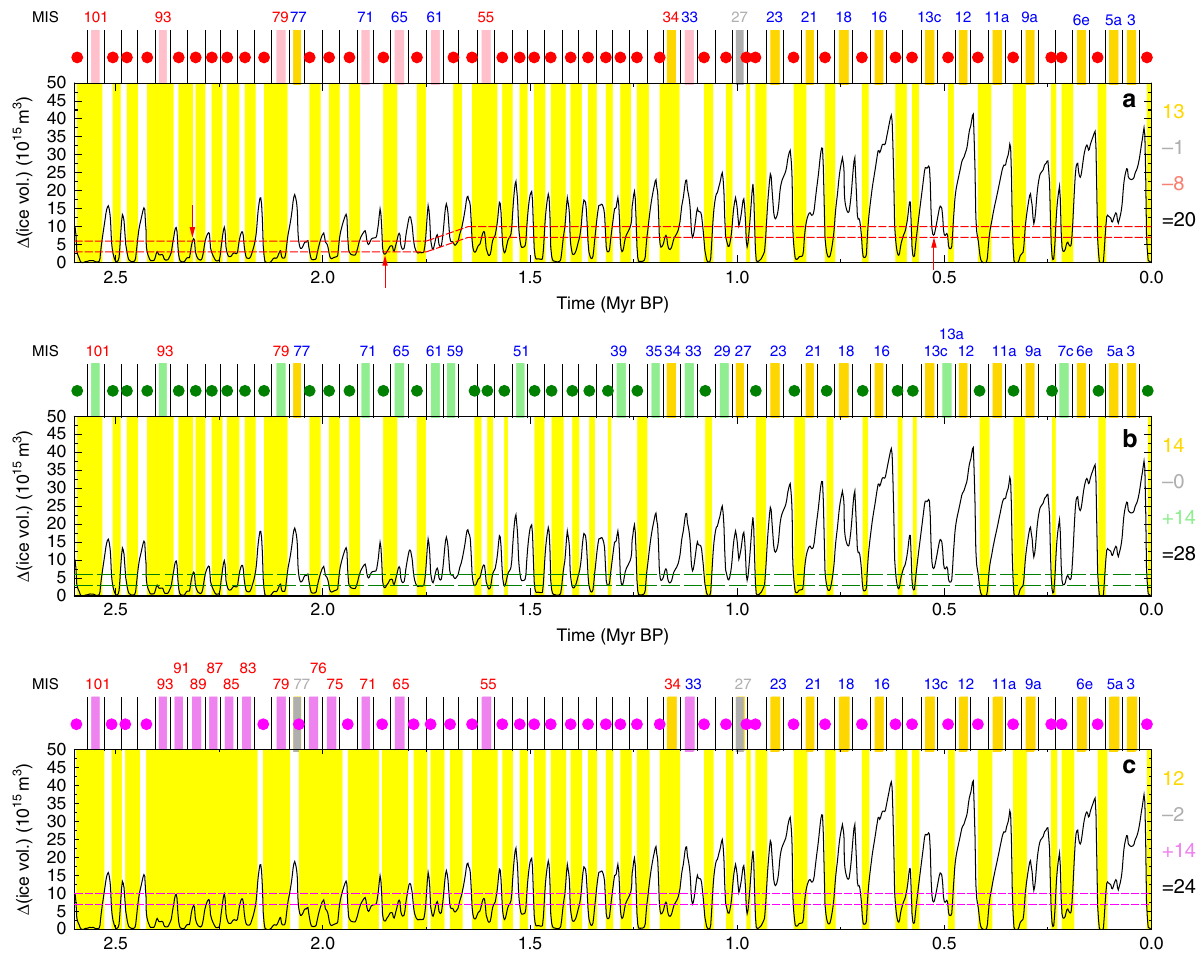
Fig. 3 Alternative de fi nitions of Quaternary interglacials based on land ice volume. Ice volume changes in North America and Eurasia are used to de fi ne interglacials. Different sets of two thresholds (broken lines) need to get crossed by the ice-volume change to identify an individual interglacial, see text for details. On top of each panel, obliquity minima (vertical lines) and the onset of each new interglacial are marked by circles, when the plotted ice volume is crossing the lower of both thresholds after having been in glacial mode (above the higher of both thresholds). Marine isotope stages (MIS) in obliquity cycles without a new interglacial are labelled for skipped terminations (blue), or continued interglacials (red). Yellow background colours mark the times from the beginning of a new interglacial to the beginning of a new glacial. Colour bars above the panels mark obliquity cycles which are without a new interglacial (gold: according to T17; pink/lightgreen/violet: additional interglacials according to this study; grey: contains interglacials according to T17, but not con fi rmed in our de fi nition). Numbers on the right summarize obliquity cycles without interglacials according to this colour code. a Standard de fi nition of thresholds, minimizing the number of obliquity cycles without interglacials (similar to Fig. 2a). Time-independent de fi nition of thresholds using values constrained ( b ) for the early or for ( c ) the late part of the